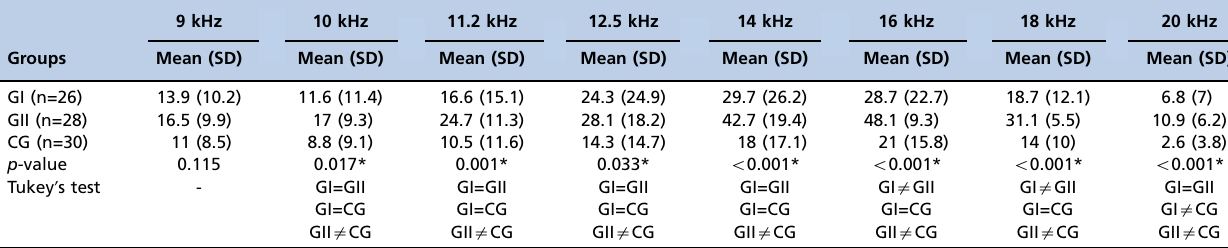
Table 2 - Mean and standard deviation (in dB HL) of the auditory thresholds from 9 to 20 kHz of both the ears, by group.